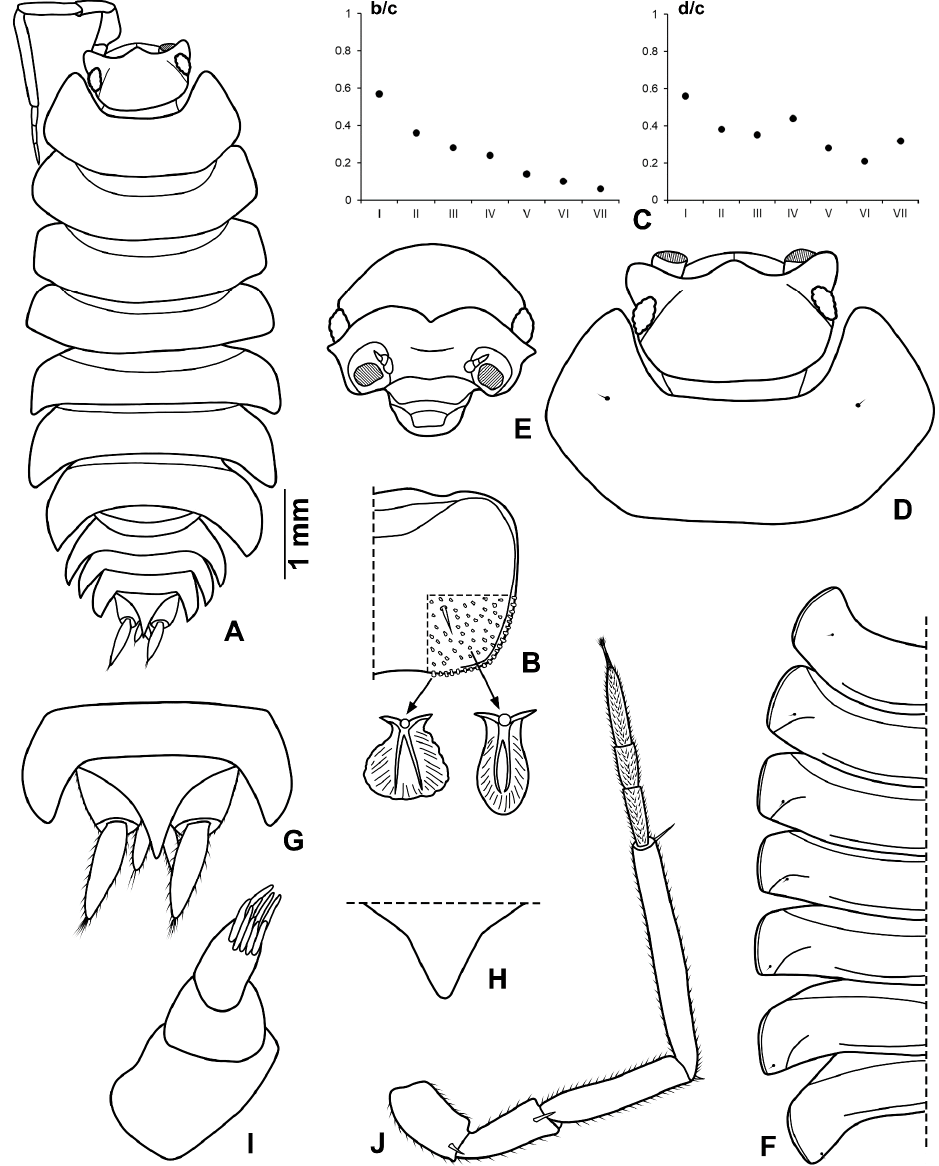
Figure 4. Sardoniscus marmoratus sp. n. ( A – D , F , G , J ) Paratype ♂ from Tann-a da Scaggia, Bargagli. ( E,H,I ) Paratype ♀ , same locality. ( A ) Specimen in dorsal view. ( B ) Right side of pereonite 2, with central and marginal scale-setae. ( C ) Coordinates of noduli laterales. ( D ) Cephalon and pereonite 1, dorsal view. ( E ) Cephalon, frontal view. ( F ) Left side of pereon showing disposition of noduli laterales. ( G ) Pleonite 5, telson and uropods, dorsal view. ( H ) Telson, dorsal view. ( I ) Antennula. ( J ) Antenna.